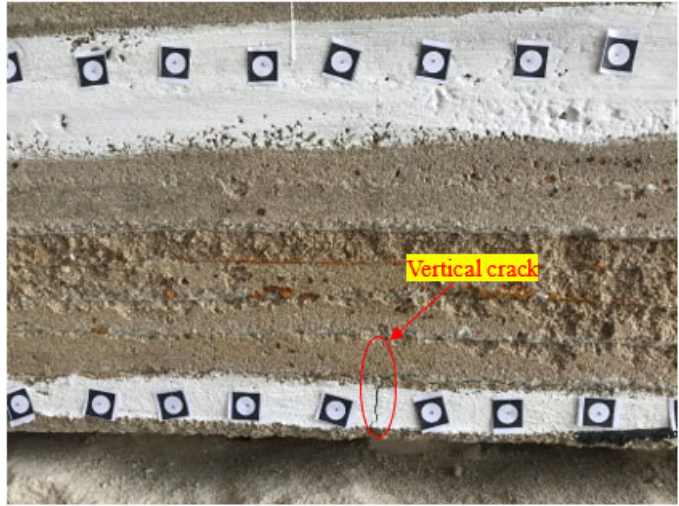
Figure 12. Vertical crack in KS1 in 4 cm mining height physical model.